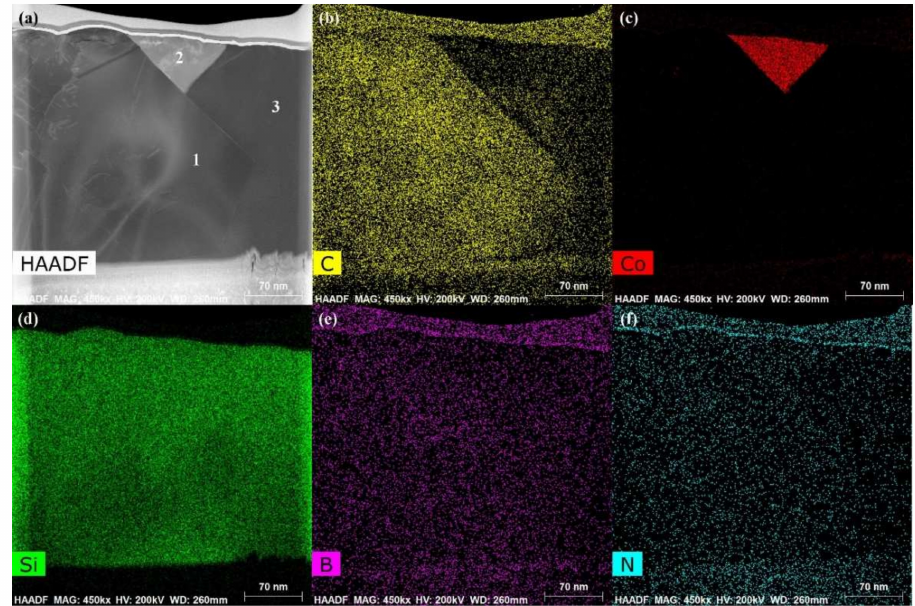
Figure 9. TEM images and the elements analysis on the area marked with a white box in Figure 7c: ( a ) Bright field image, ( b – f ) element analysis of Si, C, Co, B, and